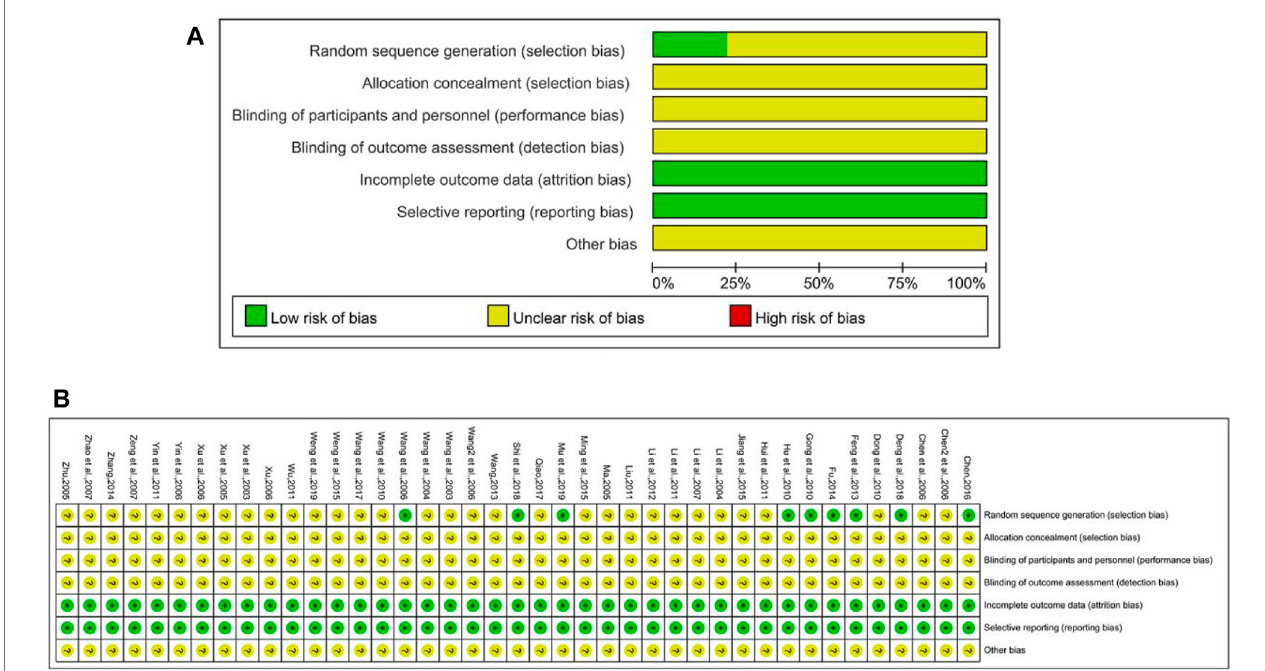
FIGURE 2 | Risk of bias graph of Included Studies (A) Risk of bias graph (B) Risk of bias summary.